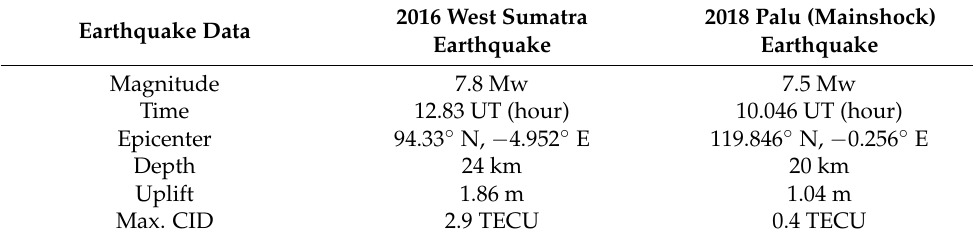
Figure 2. Trajectories of SIPs during the 2016 West Sumatra earthquake ( a ) and 2018 Palu earthquake ( c ). Time series changes in TEC for the 2016 West Sumatra earthquake at 12.4 – 13.6 UT by all satellites ( b ), GPS PRN 9 ( e , f ), 17 ( g , h ), 23 ( i , j ) and GLONASS PRN 4 ( k , l ), and also for the 2018 Palu earthquake at 9.5 – 11 UT by all satellites ( d ), and GPS PRN 21 ( m,n ) and 25 ( o , p ). The dashed vertical black line represents the time of the earthquake (the 2016 Sumatra earthquake is 12:49:48 UT and the 2018 is 10:02:45 UT), a large yellow star indicates the location of the epicenter of the earthquake, and the small black star on the trajectory indicates the location of the SIPs during the mainshock event. The comparison of the 2016 Western Sumatra earthquake and the 2018 Palu earthquake is shown in Table 1. The numbers inside the bracket at the time series ( f , h , j , l , n , p ) indicate station position. Table 1. Earthquakes